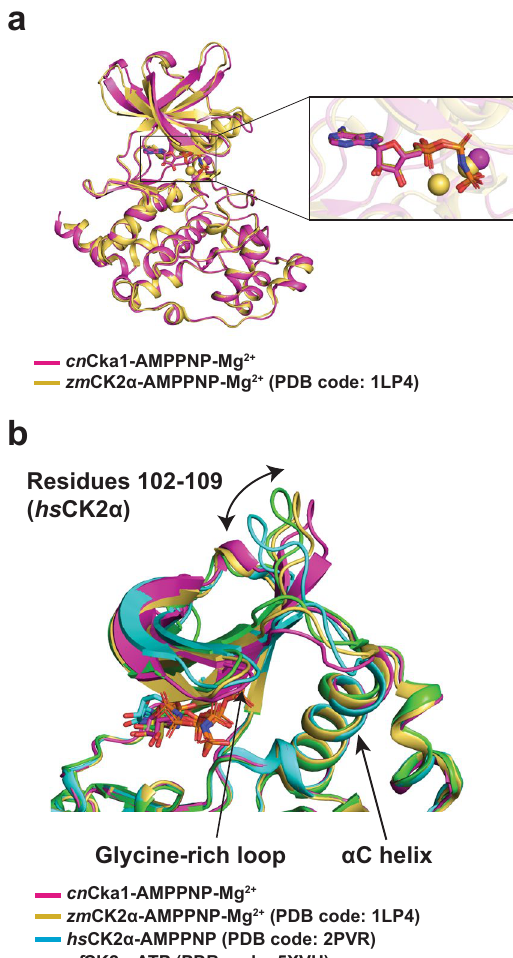
Figure 4. Structural comparisons among CK2 α orthologues. cn Cka1, zm CK2 α , hs CK2 α and pf CK2 α are shown in magenta, gold, cyan and green, respectively. Mg 2 + ions are shown as spheres and the respective co- substrates (analogues) are shown as sticks in the same colour. ( a ) Superimposition of cn Cka1-AMPPNP-Mg 2 + and zm CK2 α -AMPPNP-Mg 2 + (PDB code: 1LP4 ) with a magnified view of the AMPPNP-Mg 2 + bound catalytic site. ( b ) Structural deviations at the N-lobe of cn Cka1-AMPPNP-Mg 2 + , zm CK2 α -AMPPNP-Mg 2 + (PDB code: 1LP4 ), hs CK2 α -AMPPNP (PDB code: 2PVR ) and pf CK2 α -ATP (PDB code: 5XVU